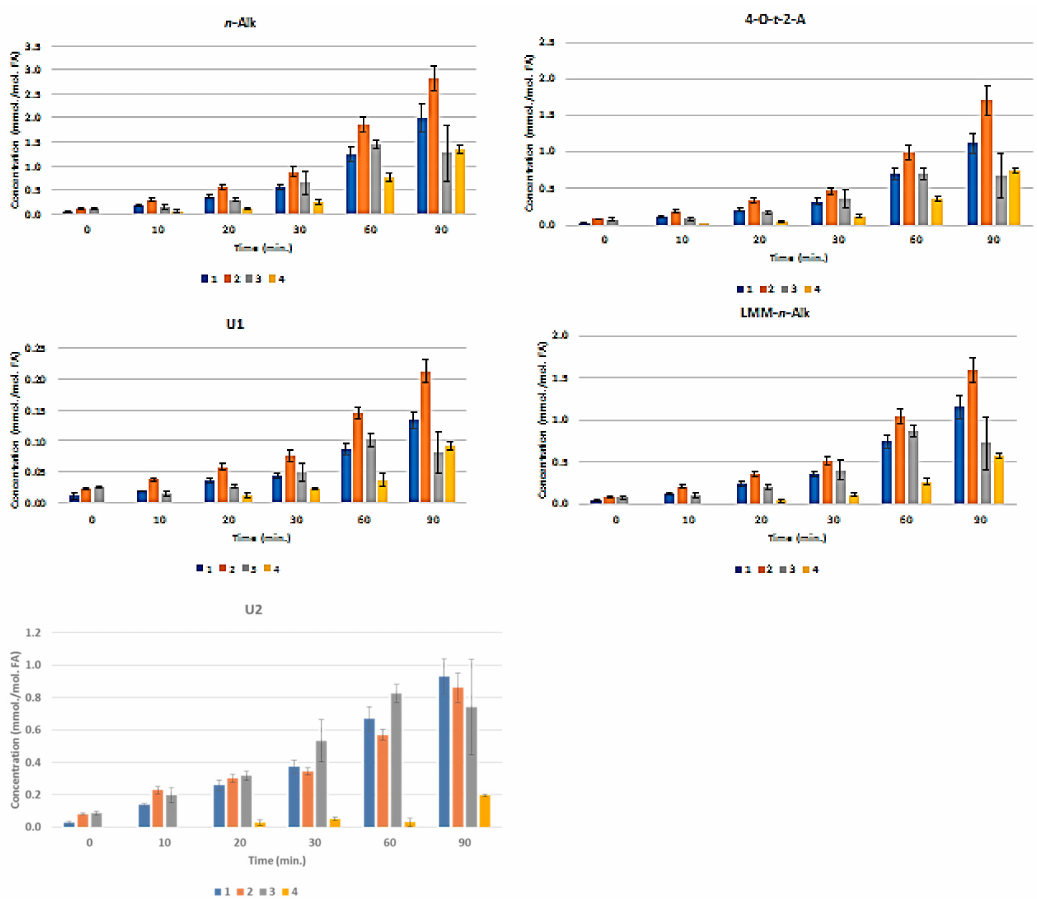
Figure 3. Mean ± SEM Aldehyde Classification Concentrations in CLO Products as a Function of TSE Duration. Time-dependence of mean ± SEM concentrations of secondary aldehydic LOPs (mmol. / mol. FA) generated in CLO products when exposed to TSEs at 180 ◦ C for periods of 0–90 min. Aldehydes monitored were trans -2-alkenals (abbreviated t -2-Alk); trans , trans -alka-2,4-dienals ( t,t -A-2,4-D); combined 4,5-epoxy- trans -2-alkenals and acrolein (4,5-E- / Acr); cis,trans -alka-2,4-dienals ( c,t -A-2,4-D); n -alkanals ( n -Alk); 4-oxo- trans -2-alkenals (4-O- t -2-A); low-molecular-mass n -alkanals ( n -Alk); unidentified aldehyde classifications (U1 and U2). Colour codes 1, 2, 3, and 4 in the abscissa axis panels correspond to designations of the CLO